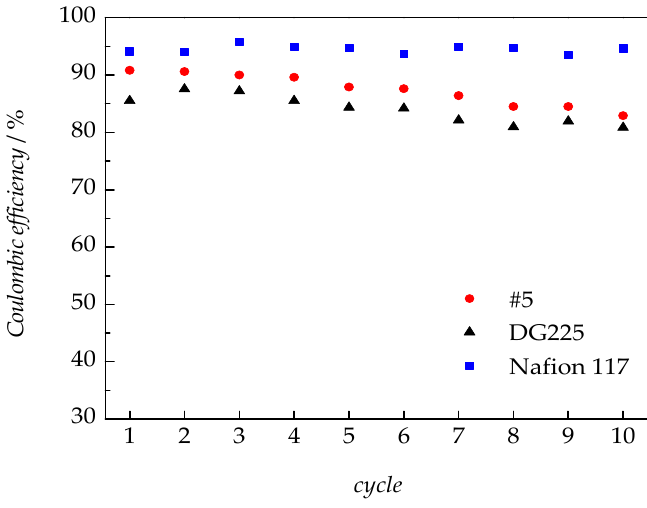
Figure 10. Coulomb efficiency of the sample #5, DG225 and Nafion.